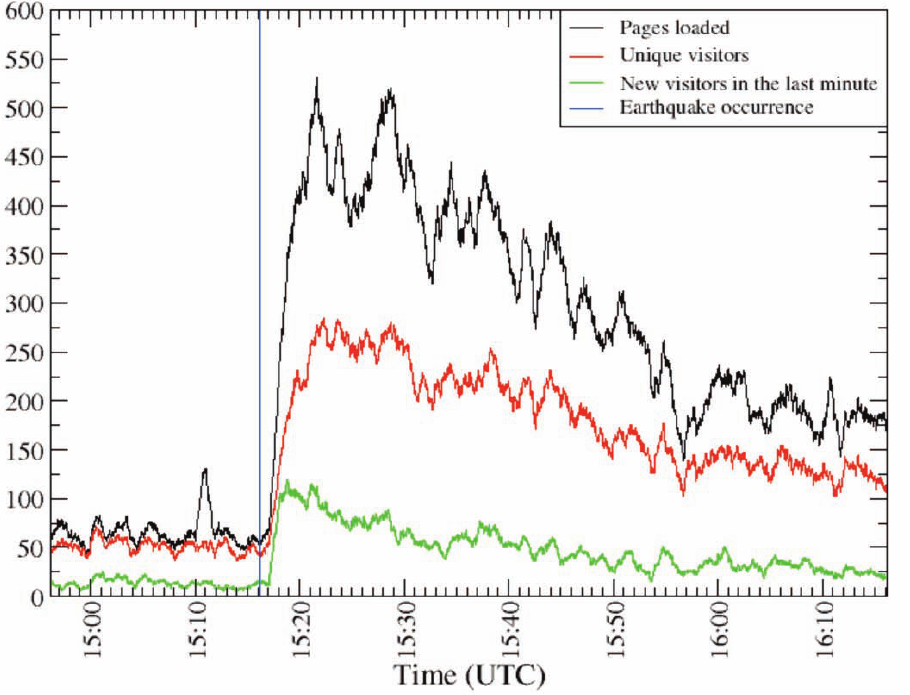
Figure 1. The different traffic metrics for the M 4.5 Vrancea (Romania) earthquake of June 6, 2010. The number of loaded pages (black line) characterizes the activity that results from all of the website visitors. The number of unique website visitors (red line) is the number of different IP addresses that loaded at least one page in the previous minute. The number of new website visitors in the previous minute (green line) is a new metric defined to reliably detect the convergence of eyewitnesses following a felt earthquake. HTTP requests from robots, referrers and pre-identified seismological institutes are systematically removed as the first step of these website traffic measurements. The vertical blue line represents the origin time of the earthquake. The first location and magnitude for this earthquake were reported on the EMSC Web site 4 min after its occurrence, while the website traffic surge was detected in 112